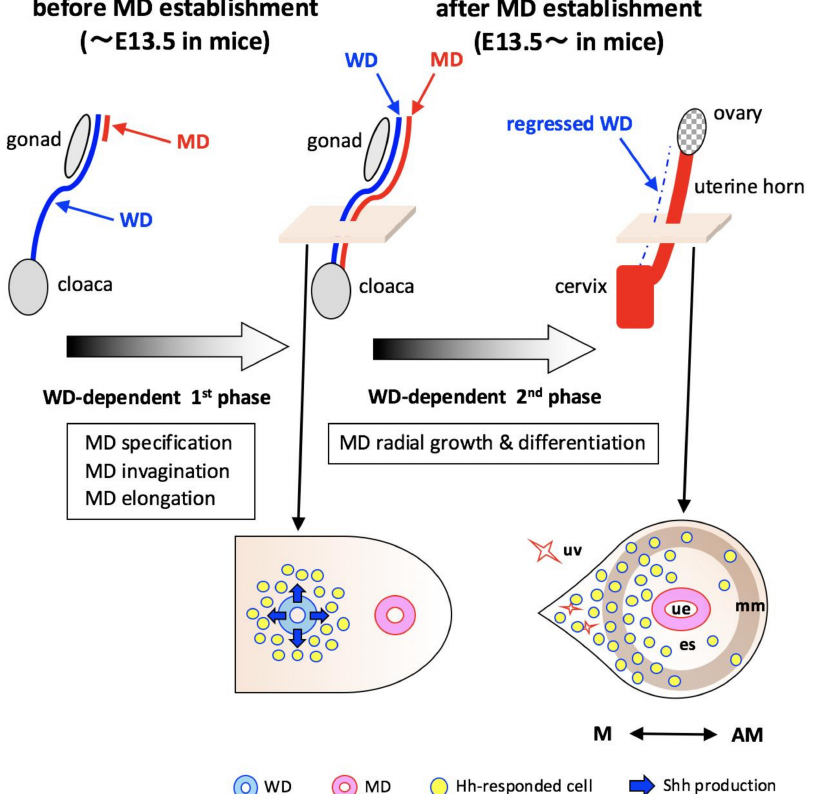
Figure 6. Model showing the developmental mechanism of WD-dependent FRT formation. This schematic model shows that the mouse FRT formation process involves two developmental phases dependent on WDs. The 1st phase (before E13.5 mice): CE cells commit to MD precursors by WD-derived inductive signals. MD precursors then invaginate and elongate caudally within the urogenital ridge towards the cloaca using WDs as “guide wires”. The 2nd phase (after E13.5 mice): after completing MD elongation, radial growth and differentiation of the MD mesenchyme and its surrounding mesenchyme are gradually initiated with the eventual regression of WDs. In this phase, cells within the urogenital ridge respond to the WD-derived Hh signal. These cells showing Hh-signal-responsiveness are localized exclusively around the WDs and continue to exist in the developing uterus after the regression of WDs and directly commit to the differentiation pathways of uterine tissue lineages, smooth muscle, endometrial stroma, and vascular vessel, mainly in their mesometrial domain. WD, Wolffian duct; MD, Mullerian duct; ue, uterine epithelium; es, endometrial stroma; mm, myometrium; uv, uterine vessel; M, mesometrial side; AM, antimesometrial